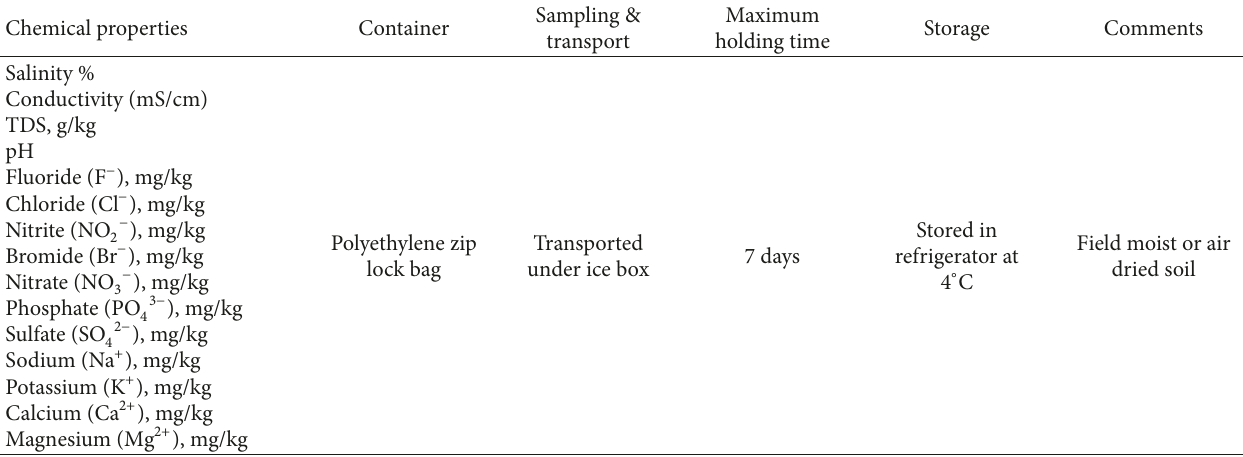
Table 4: Description of quality control (QC) for the determination of salinity indicators in soil samples across the Kalapara coastal belt in